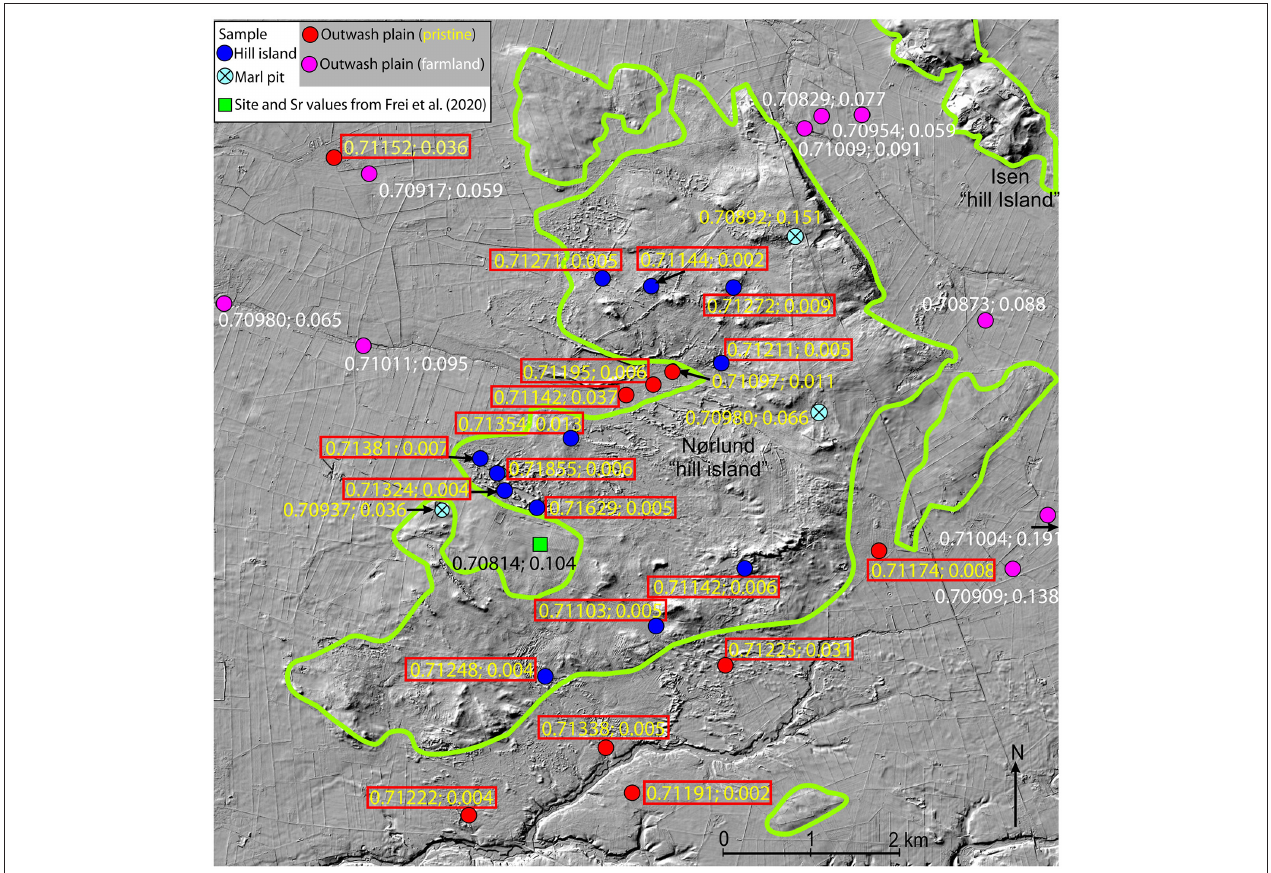
FIGURE 3 | Hillshade map of study area S1, the Nørlund hill island, and surrounding outwash plains. The outline of the “hill island” is indicated by a green line. Sample locations are indicated by colored dots (for color code see legend and Figure 4 ). For numbering of sample stations see Figure 2 . 87 Sr/ 86 Sr ratio and strontium concentration are shown for each sample. Sample stations with 87 Sr/ 86 Sr ratios exceeding the maximum value of 0.711 in the baseline for Denmark (Frei and Frei, 2011) are highlighted with a red box. Location of the site investigated by Frei et al. (2020) is marked by a green square. Map is based on free data from “Styrelsen for Dataforsyning og Effektivisering, skyggekort,